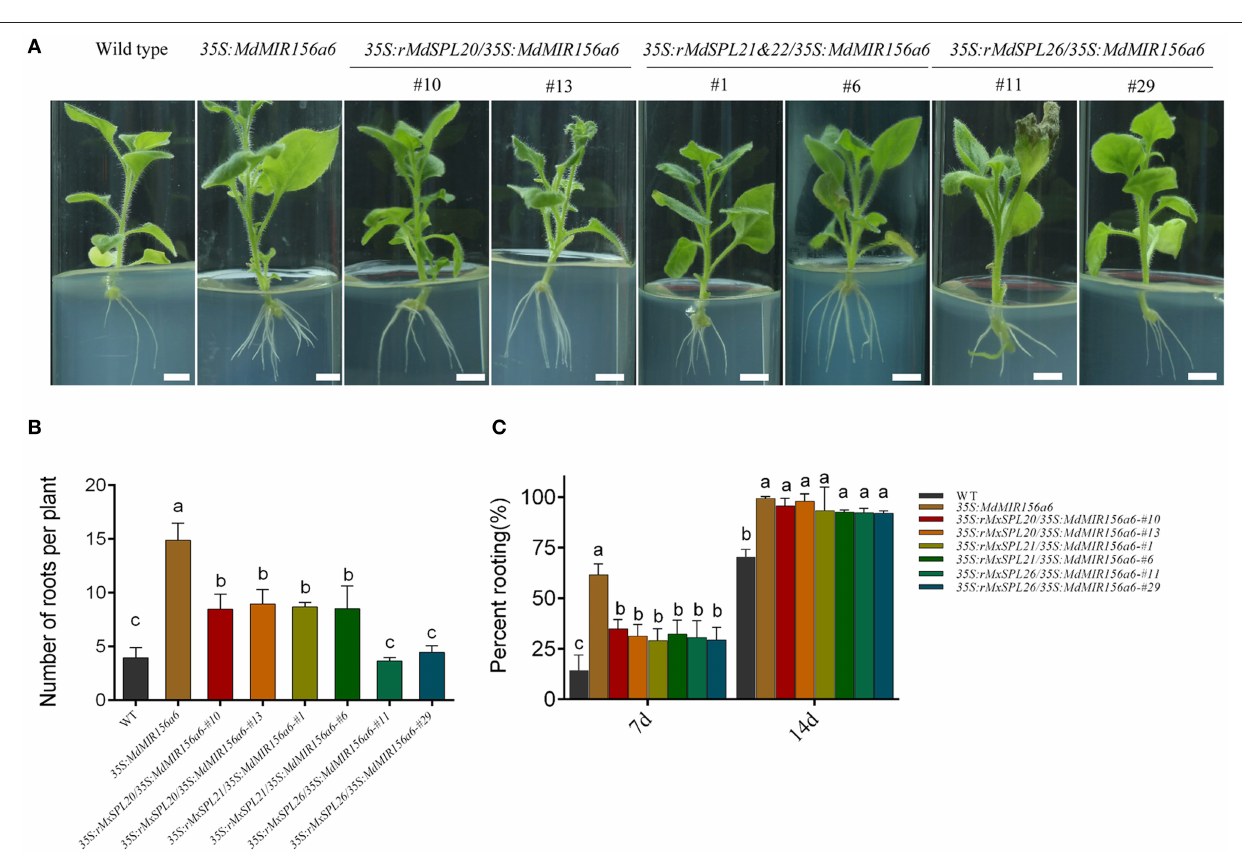
FIGURE 10 | Role of MxSPL20, 21 & 22, and 26 genes during adventitious root formation in transgenic Nicotiana benthamiana . (A) Adventitious root formation of 35S:rMxSPL / 35S:MdMIR156a6 plants. Scale bars = 1 cm. (B,C) Quantitative analysis of rooting ability of tobacco stem cuttings. (B) Adventitious root numbers per cutting were counted after 14 d on MS medium. (C) Percent rooting was investigated after 7 and 14 d of growth on MS medium. Bars show SD with three biological replicates; n = 5 for each replicate. The statistical analysis was performed by Duncan’s multiple range test at level p ≤ 0.05. The same lowercase letter indicate no significant